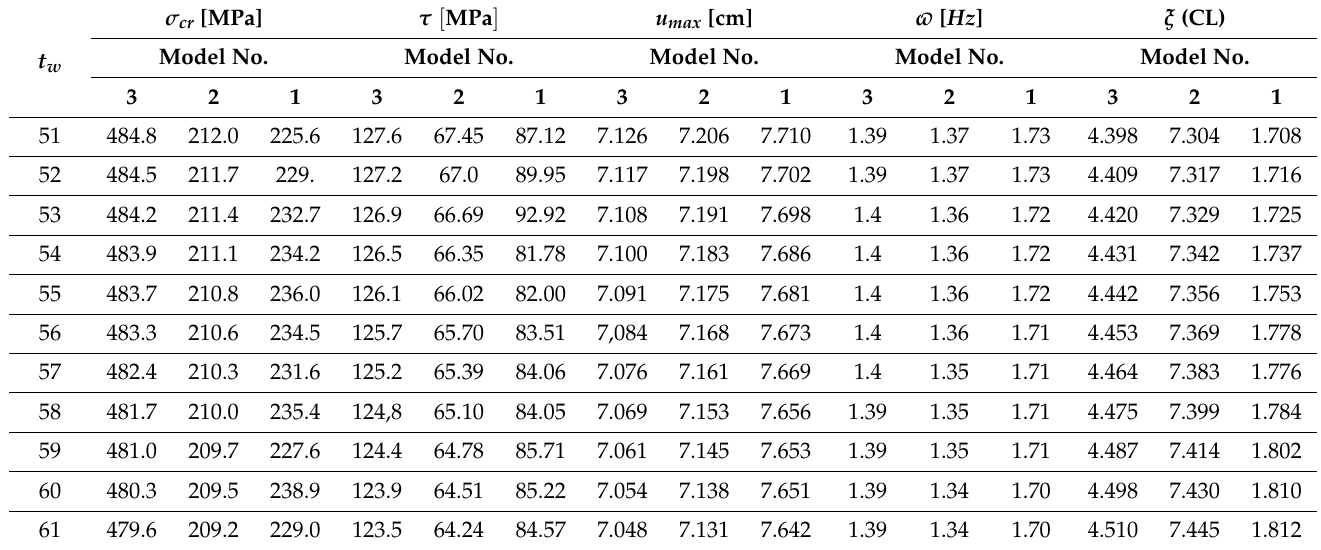
Table 4. Comparison of the results from the three FEM